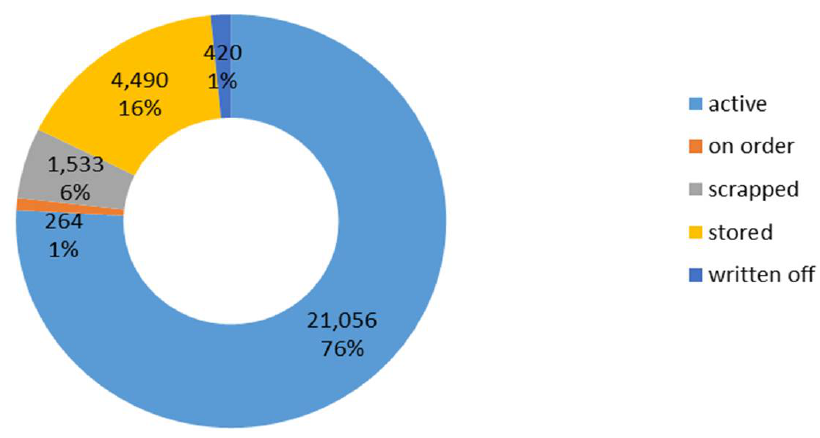
Figure 1. Worldwide Aircraft Fleet Status as of 2015 (N = 27,763).